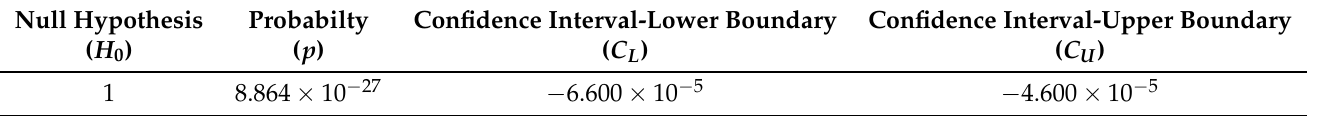
Table 2. Two-sample t -test on real-parts of MammoWave’s S 21 data. Null